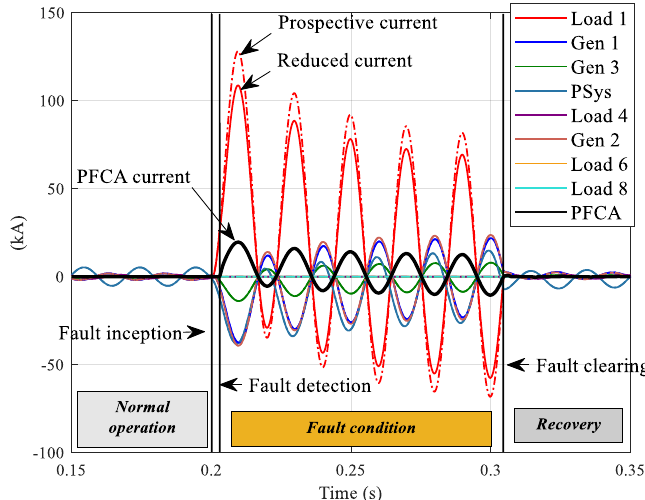
Figure 10. Current contribution of the different bays to the three-phase fault. Case without the PFCA (dotted line) and case with the PFCA (solid line).